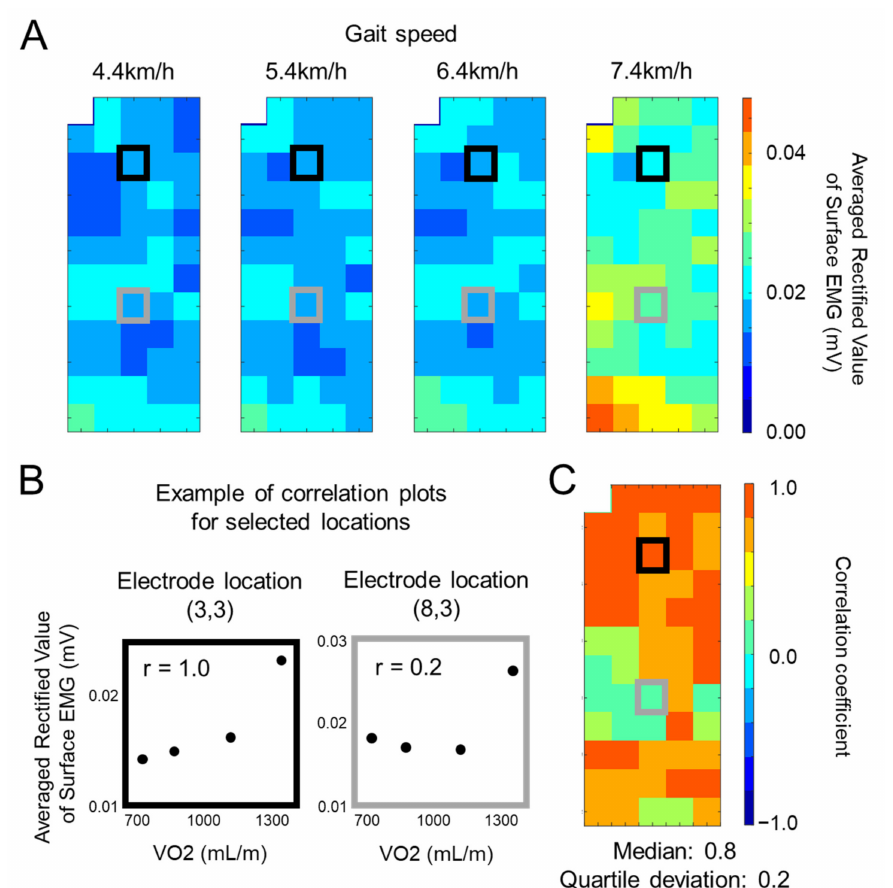
Figure 2. Representative data from the medial gastrocnemius (MG) muscle of a single participant. ( A ) Averaged rectified value (ARV) of surface electromyography at each of four different walking speeds. ( B ) Examples of correlation analysis between oxygen consumption (VO2) and averaged rectified value of surface electromyography at each of two selected electrode locations. Black and gray panels correspond to the electrode locations with black and gray boxes in ( A ) and ( C ). ( C ) Spatial distribution of correlation coefficients across all recorded